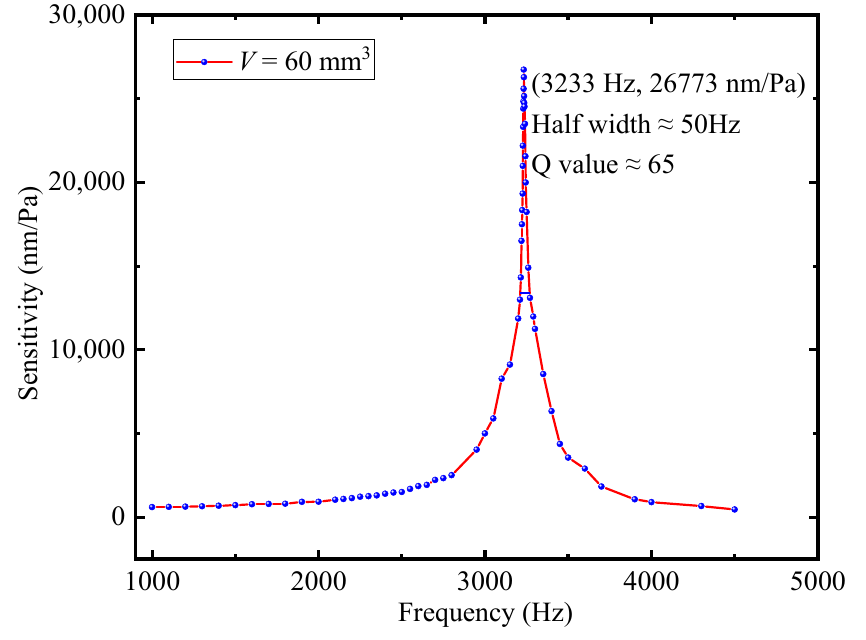
Figure 7. Frequency response of the designed FOM.